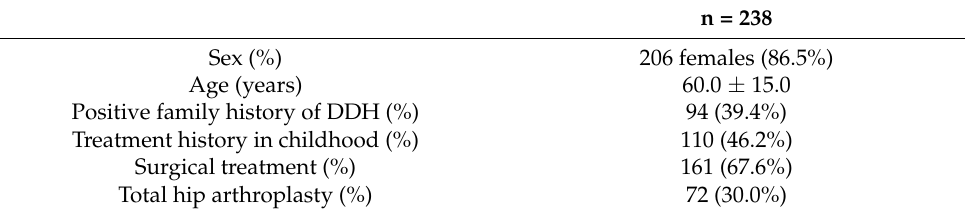
Table 1. Clinical characteristics of Japanese patients with developmental dysplasia of the hip